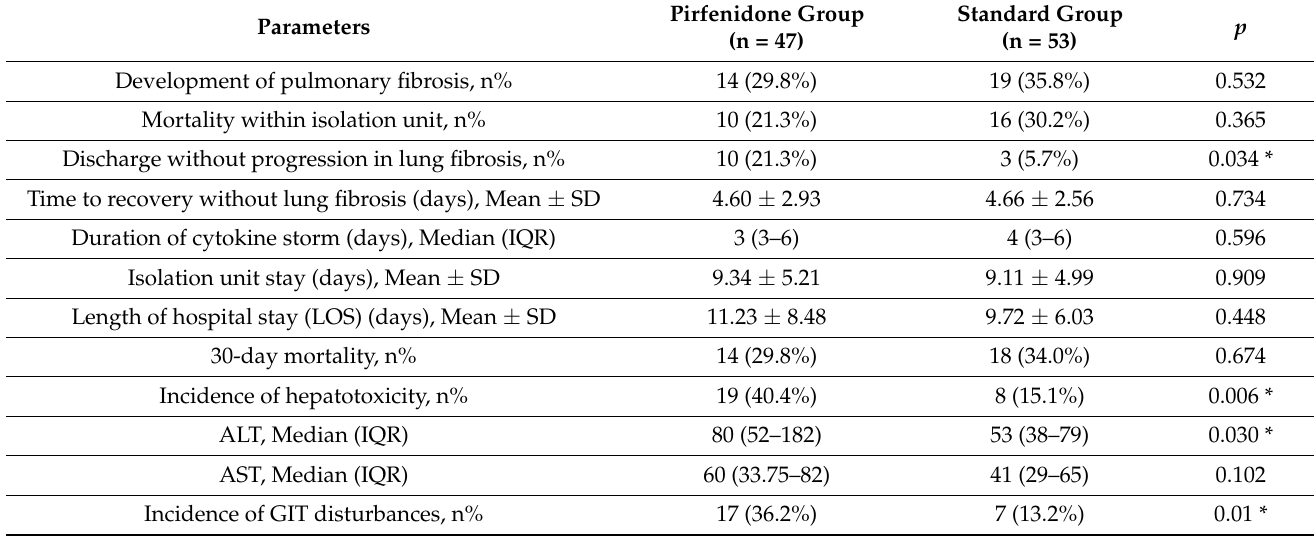
Table 5. Clinical Outcomes and follow-up in both